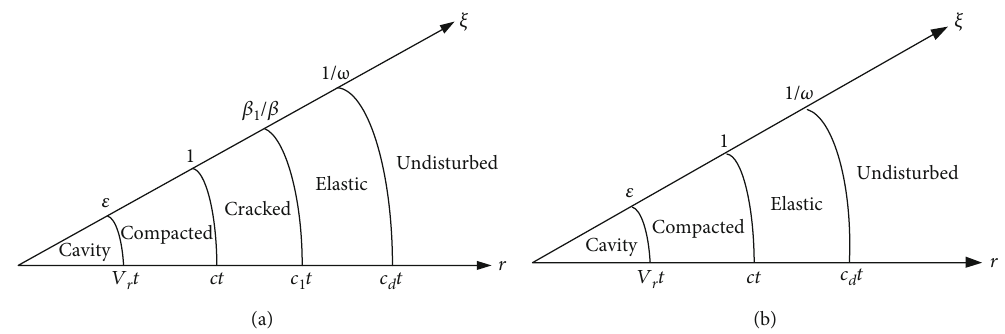
Figure 1: Two types of target responses: (a) elastic-cracked-compacted response and (b) elastic-compacted